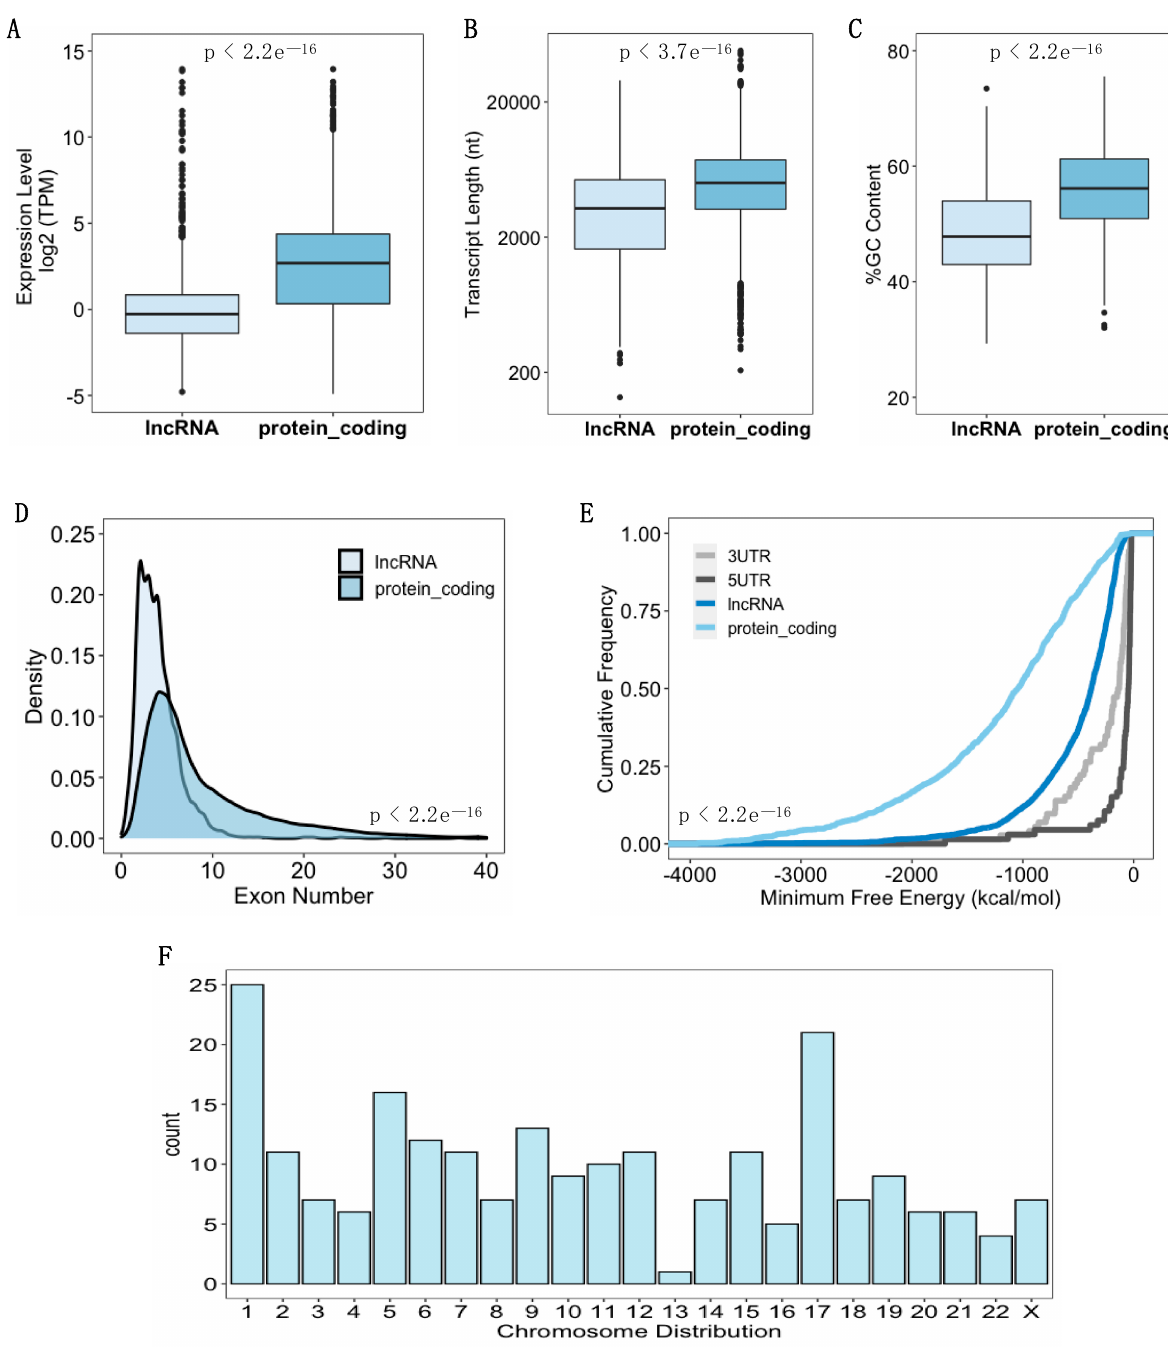
Figure 2. General characteristics of the lncRNAs identified in the Ribo-seq of hASC. ( A ) Boxplot comparing the expression levels of all lncRNAs and protein-coding genes identified in Ribo-seq. ( B ) Comparison of transcript lengths between lncRNAs and mRNAs. ( C ) Comparison of percentage of GC contents between lncRNAs and mRNAs. ( D ) Density plots show the number of exons in lncRNAs and mRNAs. ( E ) Cumulative distribution of minimum free energy (MFE) of lncRNAs, protein-coding genes, 5-untranslated-regions (5 ′ UTR), and 3-untranslated-regions (3 ′ UTR). ( F ) Histogram showing the chromosomal distribution of the lncRNAs identified in the Ribo-seq data.